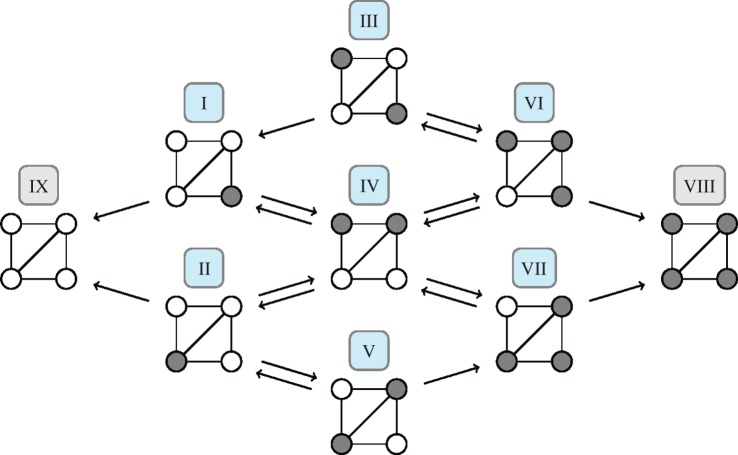
Owing to the different degrees of the nodes, the diamond has more possible states than the complete graph. There are two nodes with degree three and two nodes with degree two. Therefore, one must distinguish between those two types of nodes. For example, this leads to the distinction between states I and II, which would be the same if all nodes had the same degree. Note that even between the transient states I, II,…, VII not all transitions are bidirected. The transition probabilities TI,III and TVII,V are zero and, of course, vertical transitions are not possible. (Online version in colour.)